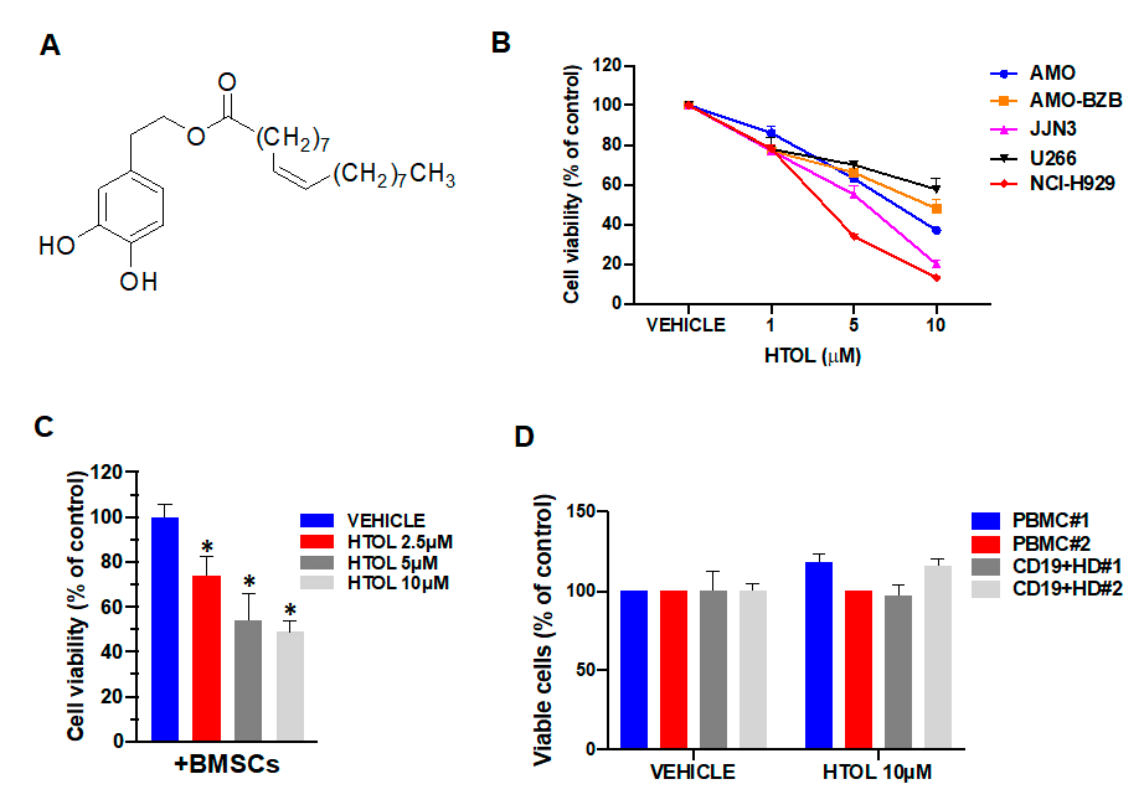
Figure 1. HTOL effects on HMCLs and PBMCs viability. ( A ) Chemical structure of HTOL. ( B ) Cell viability of HMCLs as determined by Cell Titer Glo (CTG) assay 48 h after treatment with increasing doses of HTOL or vehicle (DMSO). ( C ) Luciferase-engineered, GFP-positive NCI-H929 cells were plated adherent to MM BMSCs and treated for 48 h with HTOL;cell viability was determined by luciferase assay and expressed as a percentage of the luciferase activity of vehicle-treated cells; * p < 0.05 as compared to vehicle-treated cells. ( D ) CTG assay performed on peripheral blood mononuclear cells (PBMCs) or on purified CD19 + cells from two different healthy donors (HD), treated ex vivo with HTOL for 48 h.